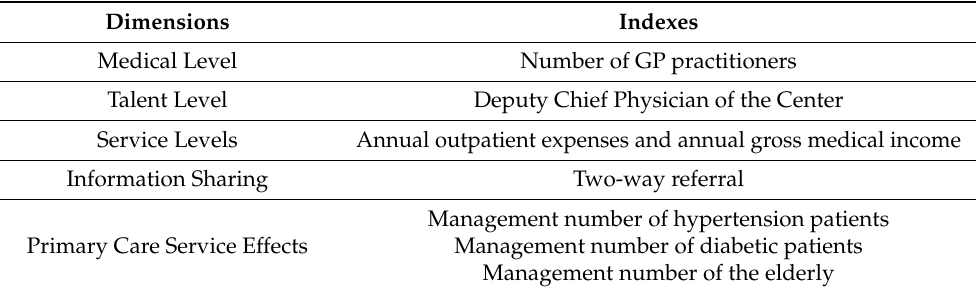
Table 3. Empirical index selection according to analyzed